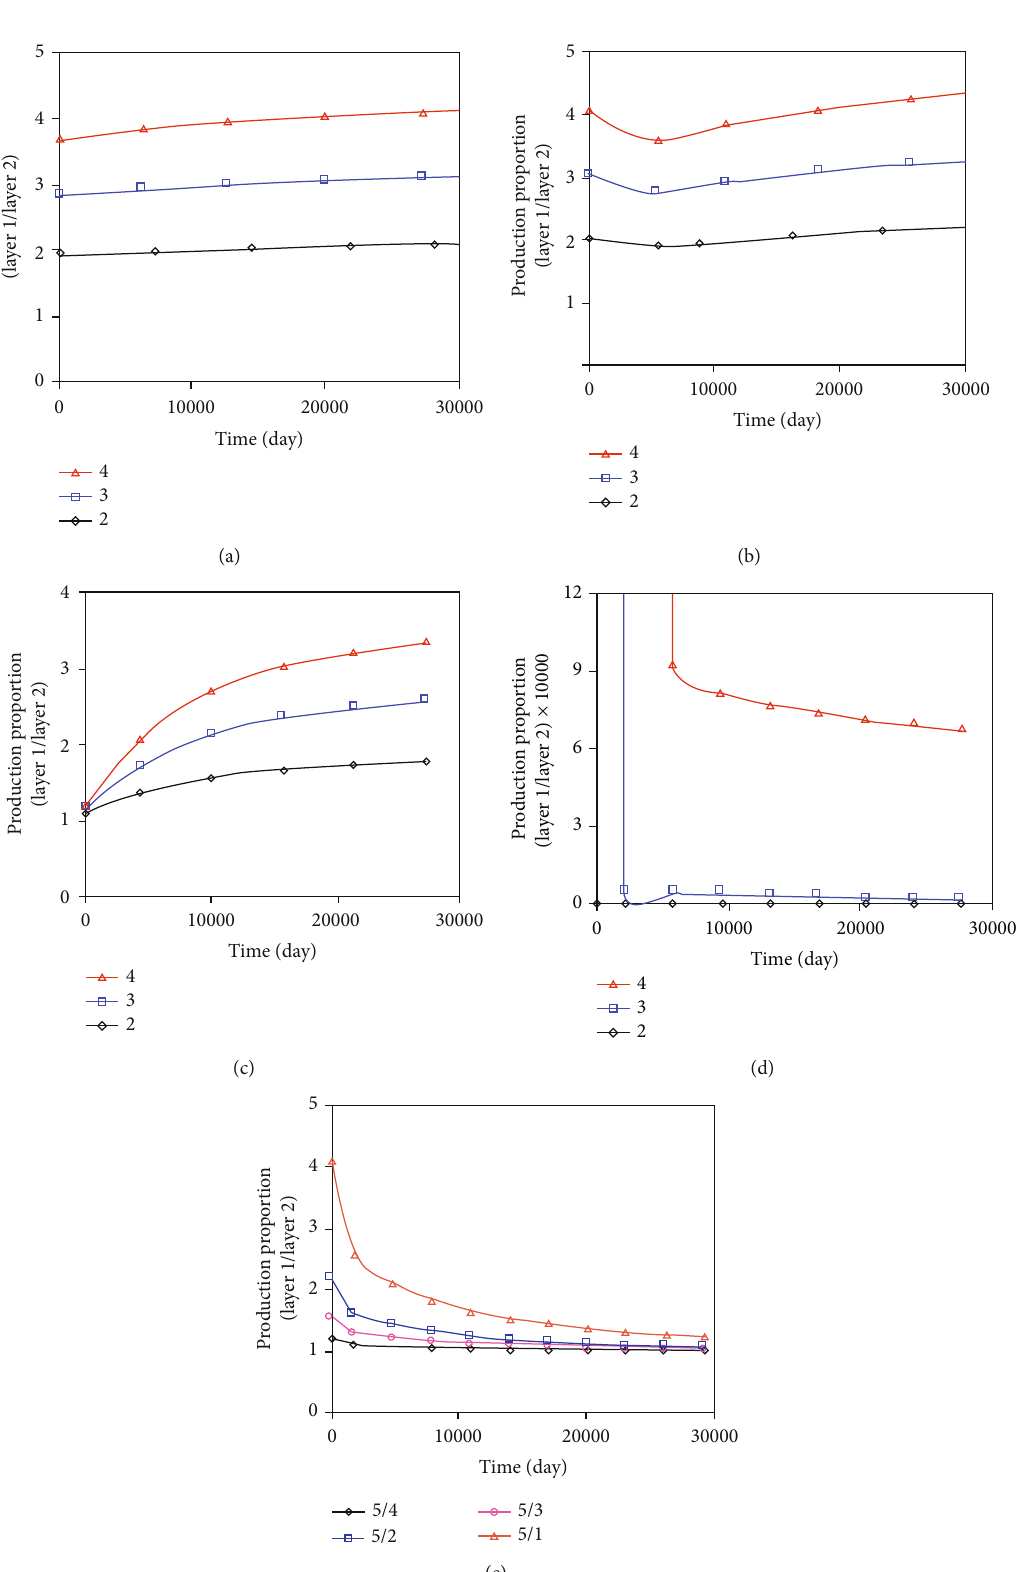
Figure 6: Sensitivity analysis. (a) The e ff ects of permeability, (b) the e ff ect of e ff ective thickness, (c) the e ff ect of porosity, (d) the e ff ect of saturation, and (e) the e ff ect of perforation